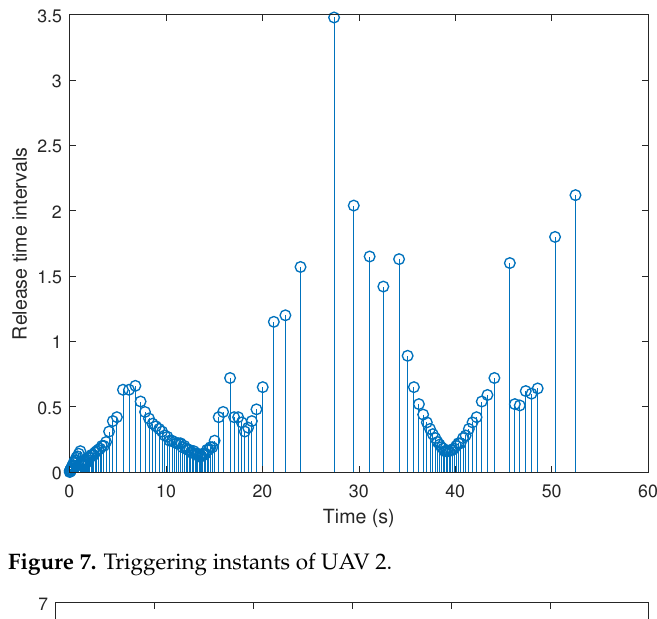
Figure 6. Triggering instants of UAV 1.